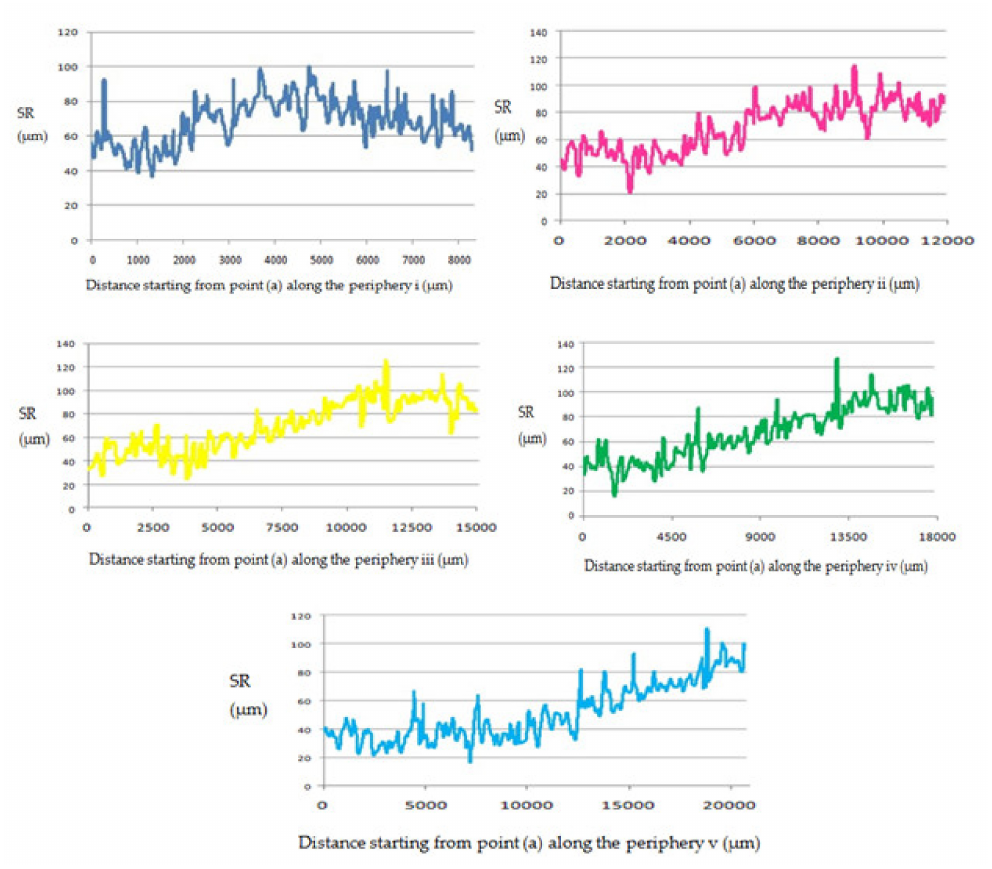
Figure 4. Roughness measurement along periphery.